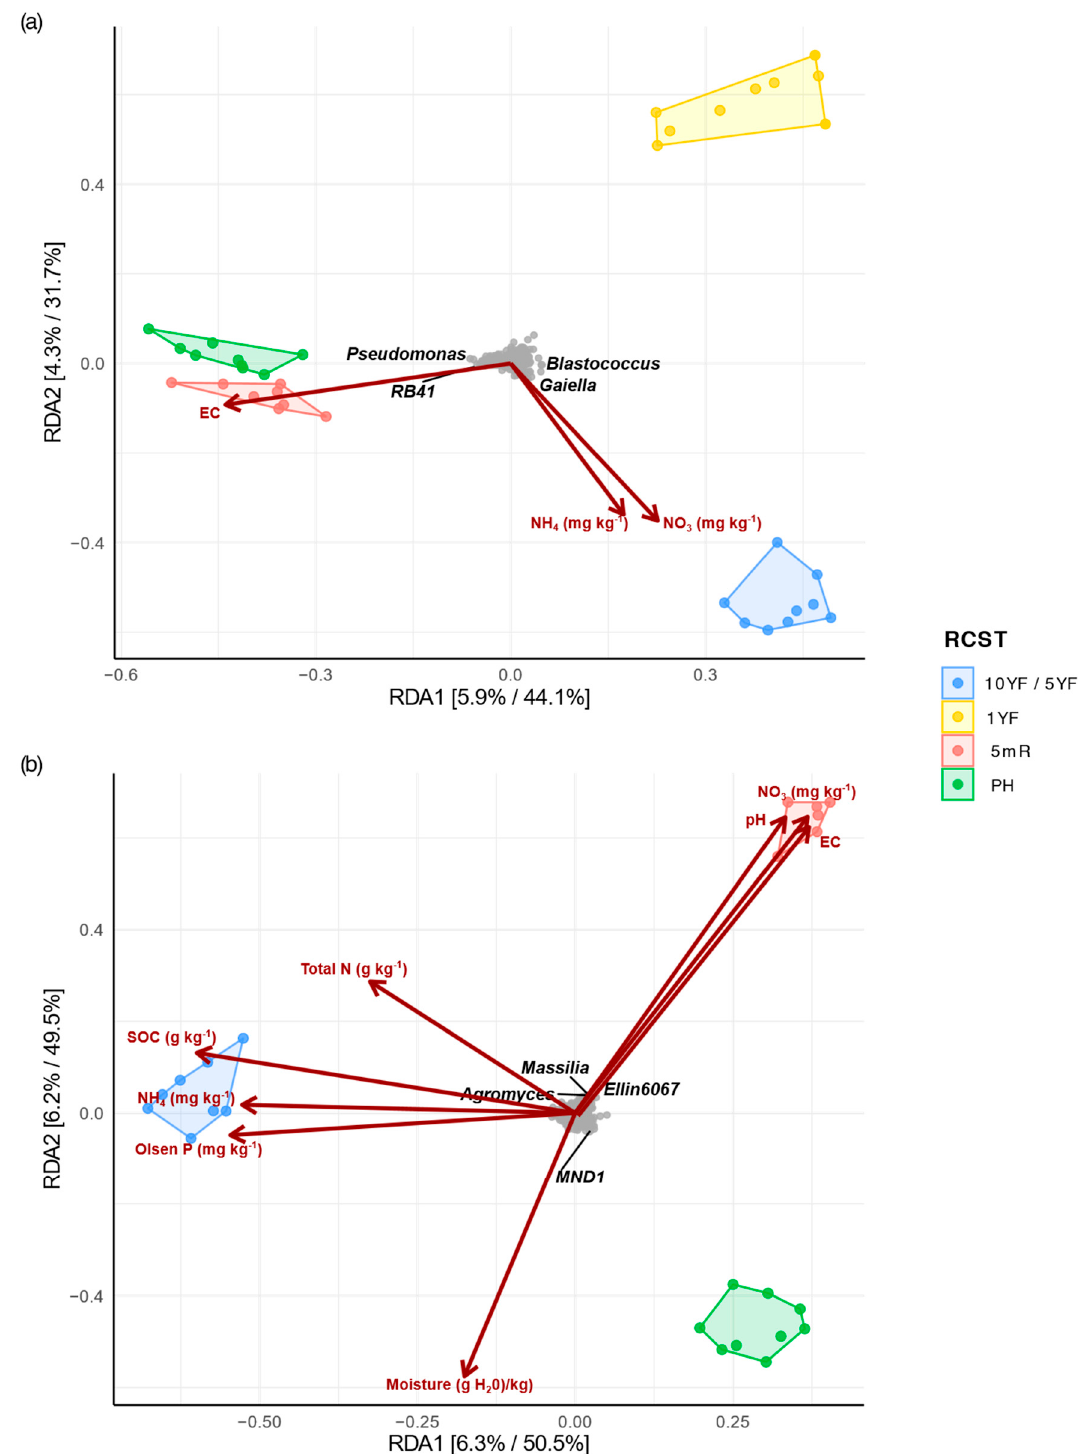
Figure 6. Constrained redundancy analysis (RDA) explaining bacterial species-environment interaction for the different RCST in Umbeluzi ( a ) and Chokwe ( b ). 10YF, ten years fallow; 5YF, five years fallow; 1YF, one year fallow; PH, postharvest; 5mR, five months off-season recovery period. “10YF/5YF” denotes fallow fields in Umbeluzi or Chokwe, respectively. Gray dots on the plot represent bacterial